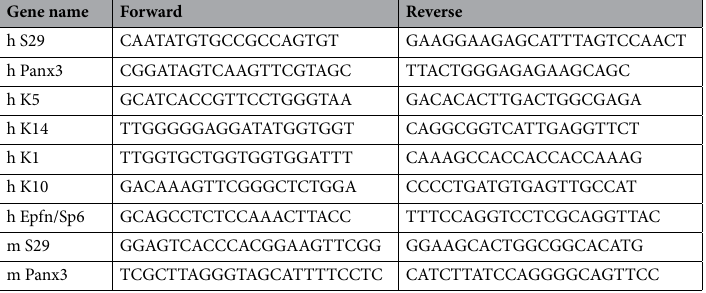
(Invitrogen)-, Cy-3-, or Cy-5 (Jackson ImmunoResearch Laboratories)-conjugated secondary antibody of 1:250 with DAPI (Sigma) 1:1000. Finally, the slides were mounted using a mounting medium (Thermo scientific. TA- 030-FM). Five samples from each time point were analyzed manually 19 . HaCaT cells (1 × 10 4 ) were seeded in a 35-mm glass bottom dish and transfected with pCMV6-mock, pCMV6- Panx3, shControl, and shPanx3 vectors, or si-Control, or si-Epfn and cultured in KM for 3 days. The cells were then fixed in 4% Paraformaldehyde Phosphate Buffer Solution (Wako, Japan) + 5% sucrose (MP Biomedicals, France) for 20 min at room temperature followed by 0.1% Triton X-100 (Sigma) for penetration for 5 min and blocked by Power Block (Biogenex) for 30 min. Primary antibodies were applied at 4 °C overnight and were detected by Alexa Fluor 488 (Invitrogen)-, Cy-3-, or Cy-5 (Jackson ImmunoResearch Laboratories)-conjugated secondary antibody of 1:250 with DAPI (Sigma) 1:1000. Immunostaining imaging was performed on a laser scan- ning A1R MP confocal microscope (Nikon) equipped with plan apo 20 × (NA = 0.75), plan fluor 40 × (NA = 1.30), and plan apo 60 × (NA = 1.4) objectives. Rabbit anti-Panx3 antibody, inhibitory Panx3, and scrambled peptides 15 , and Rabbit anti-Epfn antibody 23 have been described previously. Mouse anti-connexin 43 (Thermofisher. 138300), Rabbit anti-Notch1 (Cell Signaling Technology. 3608s), Rabbit anti-Ki67 (abcam, ab833Rabbit anti-Filaggrin (Biorbyt. Orb101353) antibodies were used. ImageJ software (version 2.0.0-rc-69/1.52p, https ://image j.net; provided in the public domain by the National Institutes of Health, Bethesda, MD, USA) is used to analize the quatification of fluorescence intesity. Open figures in ImageJ and turn the RGB figure to RGB stack (Image > Type > RGB stack). Select the stack to work on. Open Threshold (Image > Adjust > Threshold), adjust the threshold to the area of target signals. Use the same setting to evaluate the other figures in the same assay. The fluorescence intensity or the ratio of fluorescence intensity of Panx3 +/− to Panx3 −/− is evaluated. For calculating the percentage of Ki67 positive cells, four views of each cell condition were randomly selected. The total number of nuclei and the nuclei with positive Ki67 signals were counted with ImageJ. RT‑PCR. Total RNA from cells or skin tissues was extracted using the RNeasy Mini Kit and RNase-Free DNase set (Qiagen, USA) according to the manufacturer’s instruction. The RNA was reverse transcribed using the iScript (Bio-Rad.1708840). Total RNA (0.5 μg) was used for reverse transcription to generate cDNA, which was used as a template for PCRs with gene-specific primers. Primers were designed with Mac Vector software (version 17, https ://macve ctor.com/index .html) (Table 1). Real-time PCR amplification was performed with iQ SYBR Green Supermix (Bio-Rad. 64047529) and a C1000 thermocycler (Bio-Rad). Real-time PCR was per- formed for 45 cycles at 95 °C for 20 s, 60 °C for 20 s, and 72 °C for 20 s. Ribosomal protein S29 was used to normalize gene expression in the samples. All reactions were run in triplicate 19 . Flow cytometry analysis. HaCaT cells (1 × 10 6 ) were seeded in a 10-cm dish and transfected with pCMV6-mock and pCMV6-Panx3 vectors and cultured in KM for three days. The cells were then collected by centrifugation at 120 × g for five min, and fixed with cold 70% ethanol for 24 h followed by washing twice with PBS and staining with PI/RNAse solution (Thermofisher) for 15 min in the dark. The DNA content was analyzed with CellQuest software (http://www.icms.qmul.ac.uk/flowc ytome try/flowc ytome try/guide s/CellQ uest%20use r%20gui de.pdf) on FACSCalibur Station (Becton Dickinson). Western blot analysis. HaCaT cells were lysed in Mammalian Cell Lysis Buffer (Abcam. Ab179835) with a halt protease inhibitor cocktail (Thermo Scientific. Rockford IL. USA 78437) on ice. Cells lysis was ultrasonic on ice, done five times with a rotation of 15 s at 1 Hz action and a 15-s stop. Protein concentrations were deter- mined by the BCA kit (Thermofisher. 23225). Ten μg of protein from each group were resolved on sodium dode- cyl sulfate (SDS)-polyacrylamide gels (Thermofisher. NP0342) and then transferred onto polyvinyl difluoride membranes (Thermofisher. IB401002). Primary antibodies, Rabbit anti-Epfn 23 , Goat anti-Panx3 (Santa Cruz. sc-51386), Mouse anti-phospho-Akt (Cell Signaling. 4051s), Rabbit anti-Akt antibody (Cell Signaling. 9272), Rabbit anti-phospho-NFAT antibody (Thermofisher. PA5-64484), Mouse anti-NFAT (BD Biosciences. 556602), Mouse anti-Notch1 antibody (Thermofisher. MA5-11961) were used to detect the corresponding proteins. West-